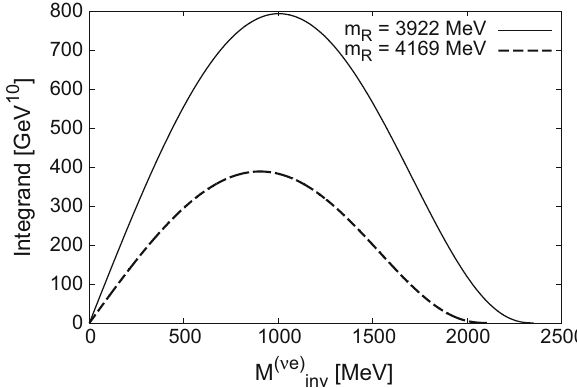
Fig. 6 The integrands of the integral that appears in Eq. (32) as a (ν e ) for the resonance mass X ( 3930 ) of M R = 3922 MeV function M inv and the resonance mass X ( 4160 ) of M R = 4169 MeVlabelfig